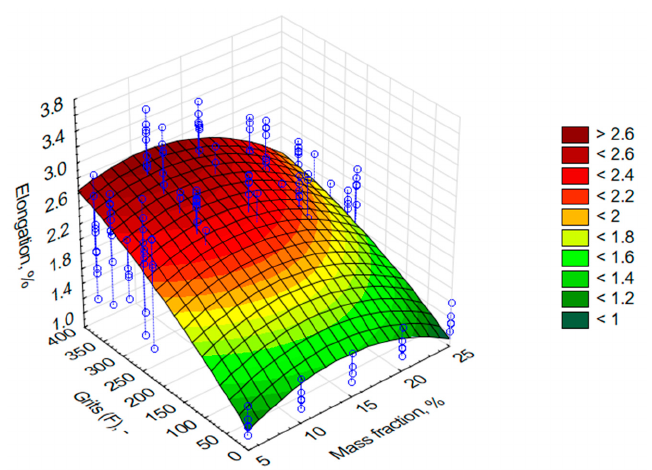
Figure 7. Graph of max principal stress values for samples made with L285 resin and H285 hardener with an addition of alundum with the following grains: F220, F240, F280, F320, and F360, with various percentage mass shares.